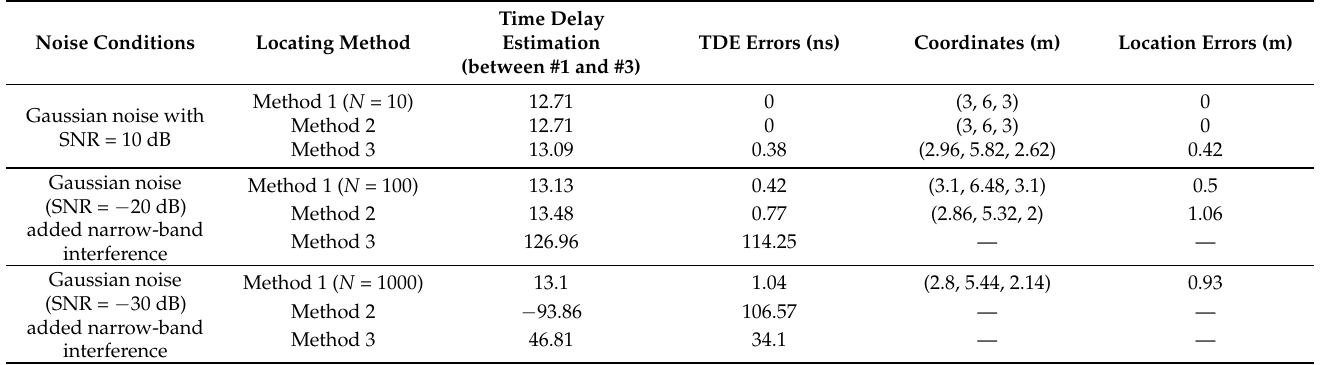
Table 1. Comparison of location results among the three methods.